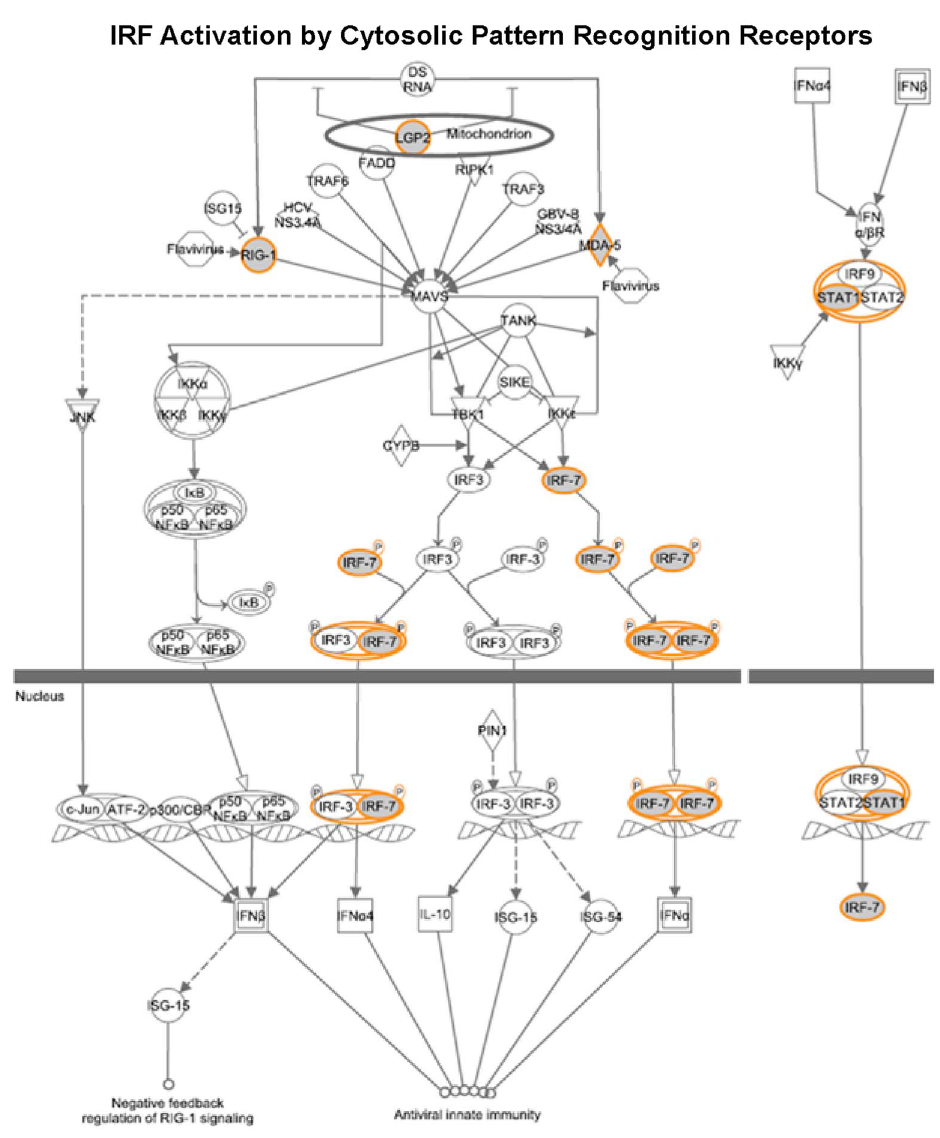
Figure 5. Genes in IRF activation by cytosolic pattern recognition receptors are associated with IFN responsiveness. The gene network was generated using Ingenuity Pathway Analysis software. Genes upregulated in nonresponders (shown in Figure 1 and 2) were highlighted.